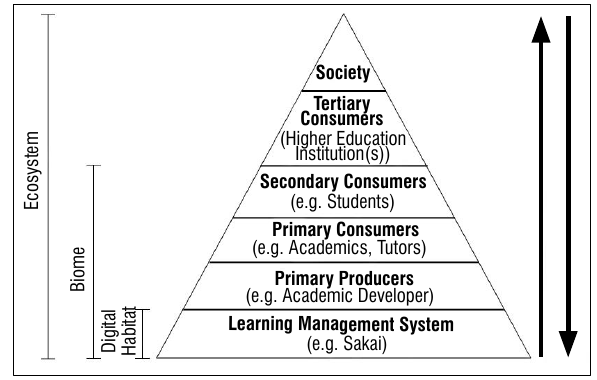
Figure 1: Ecosystem of e-learning